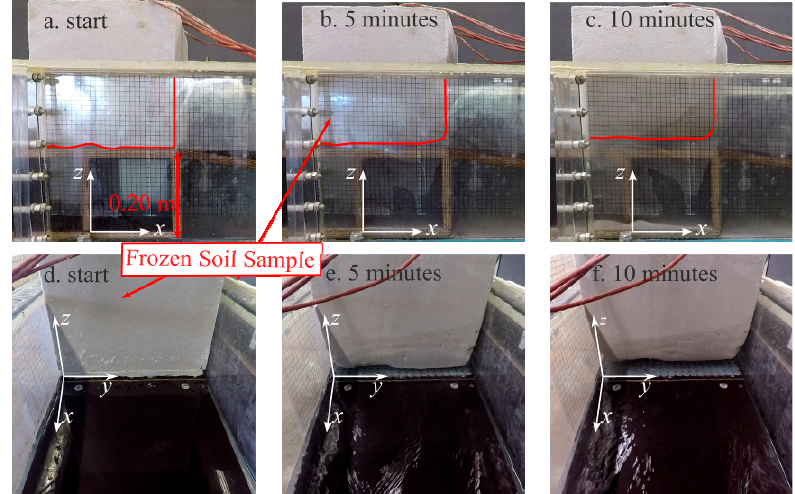
Figure 11. Frozen soil specimen in the flume. The specimen was exposed to a regular wave train (for details see Table 2). The red line marks the development of the thermoerosional niche at the start, after 5 and 10 min. The development of the soil specimen’s front side at the same time. Panels ( a – c ) show a side-view of the frozen soil, while panels ( d – f ) present a front view, with time instants ‘start’, ‘5 min’, and ’10 min’ subsequently.